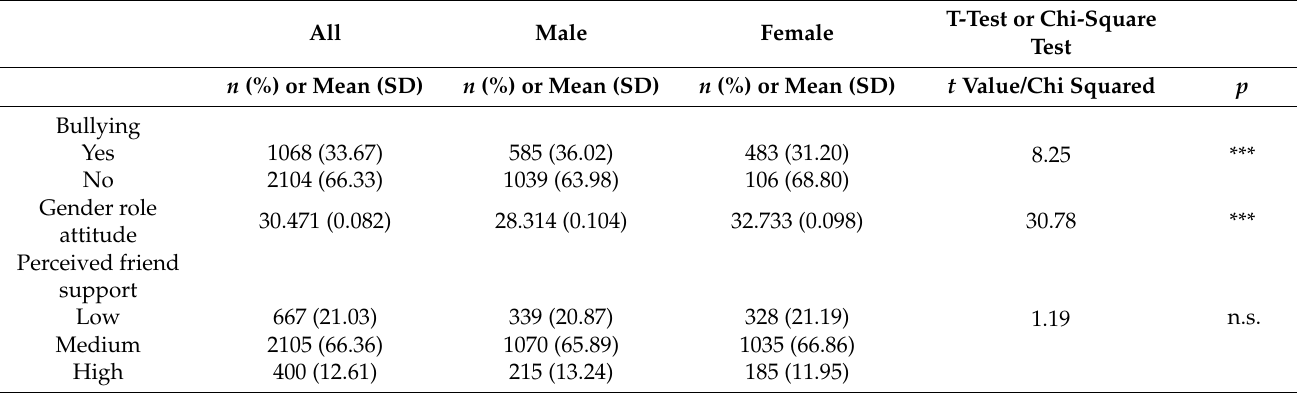
Table 2. Description of bullying perpetration, gender role attitudes, and perceived friend support for male (1624) and female (1548)